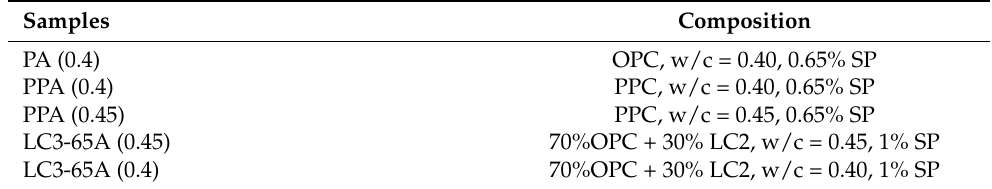
Table 3. Samples in